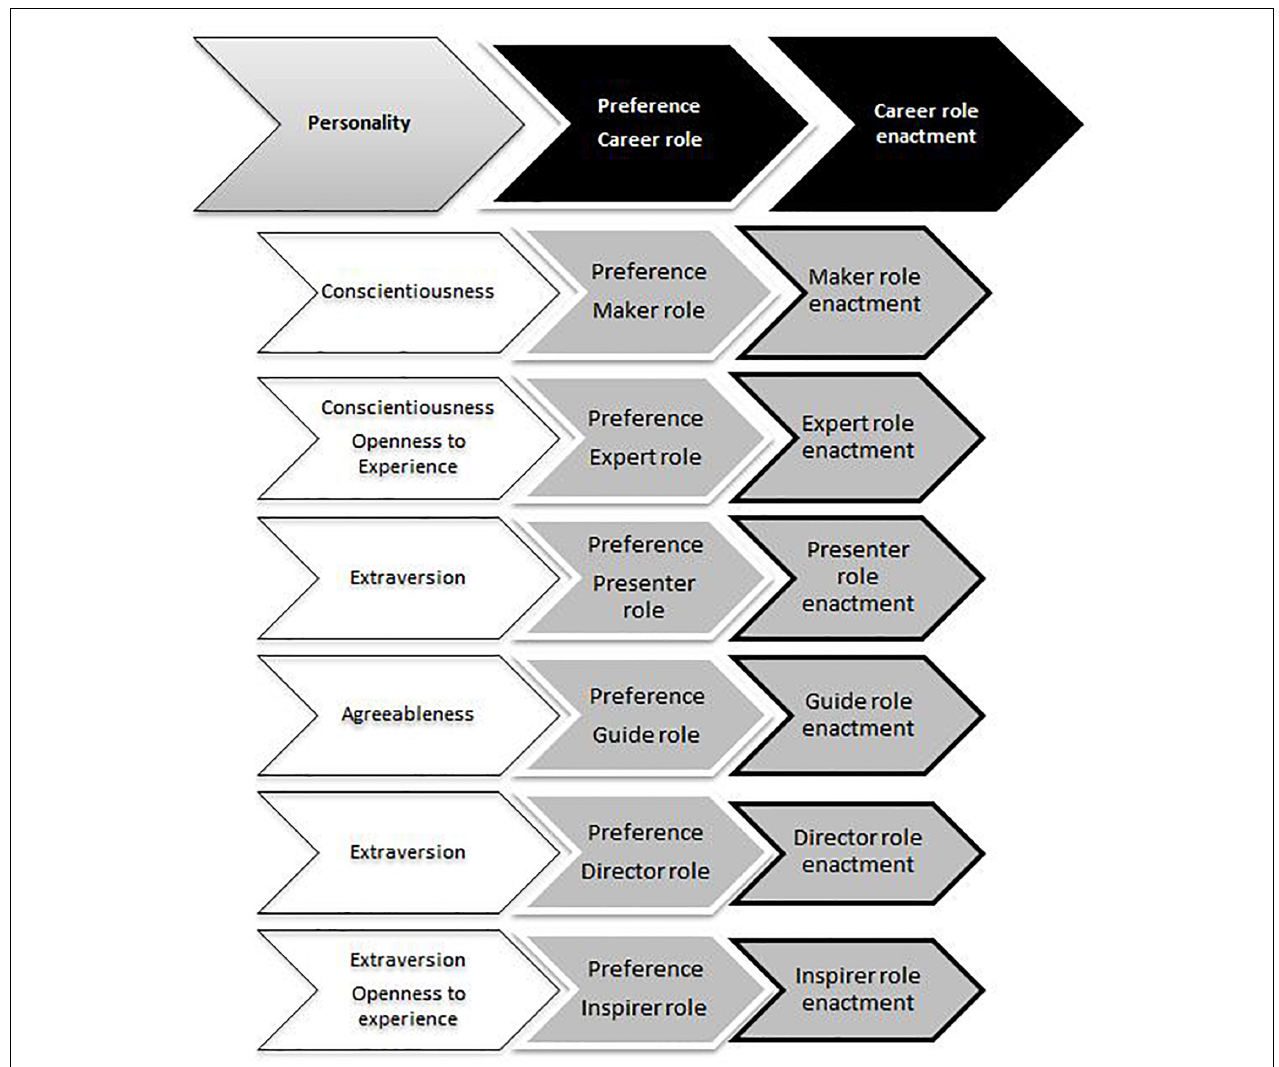
FIGURE 1 | Conceptual model of how personality traits relate to career role preferences and career role